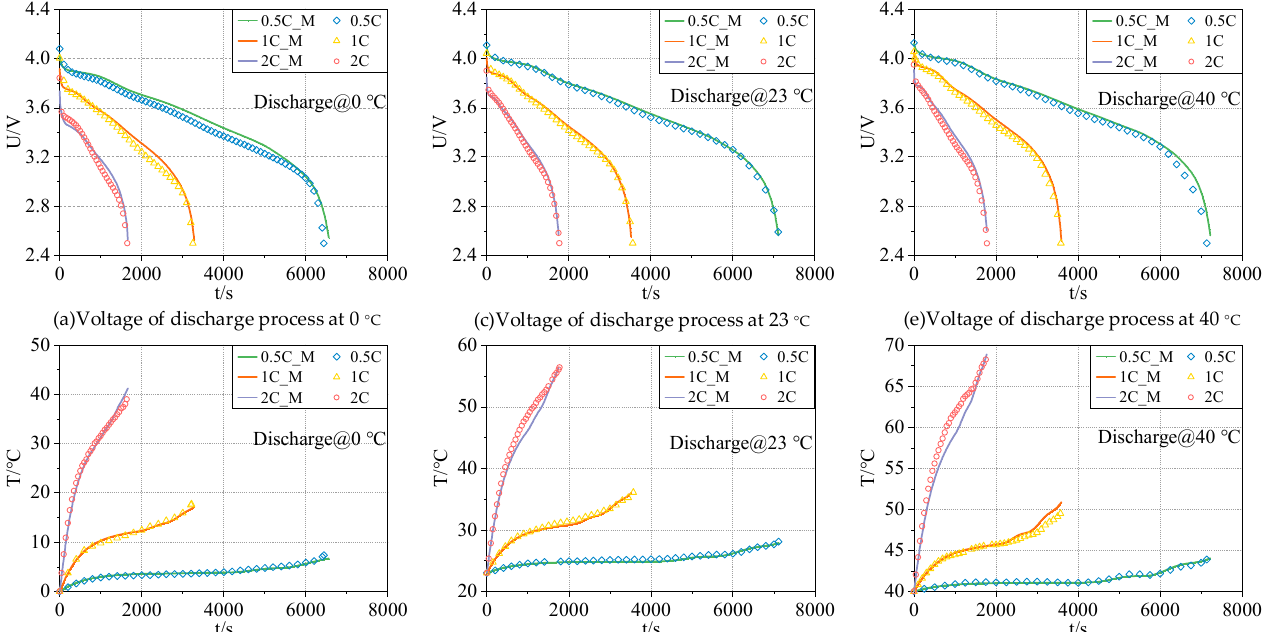
Figure 4. Validation of new battery discharge voltage and surface temperature rises under different conditions.